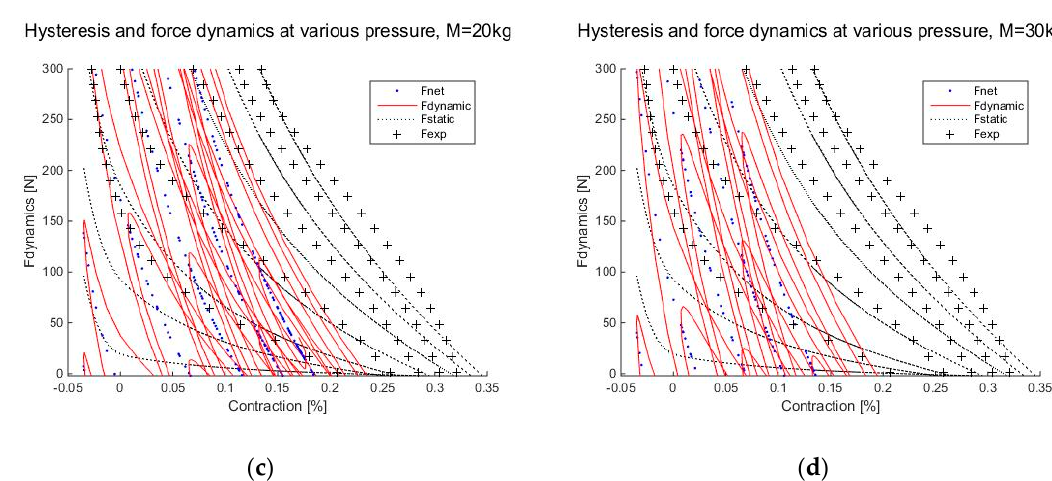
Figure 5. Force dynamics characteristics at various static load and input pressure.